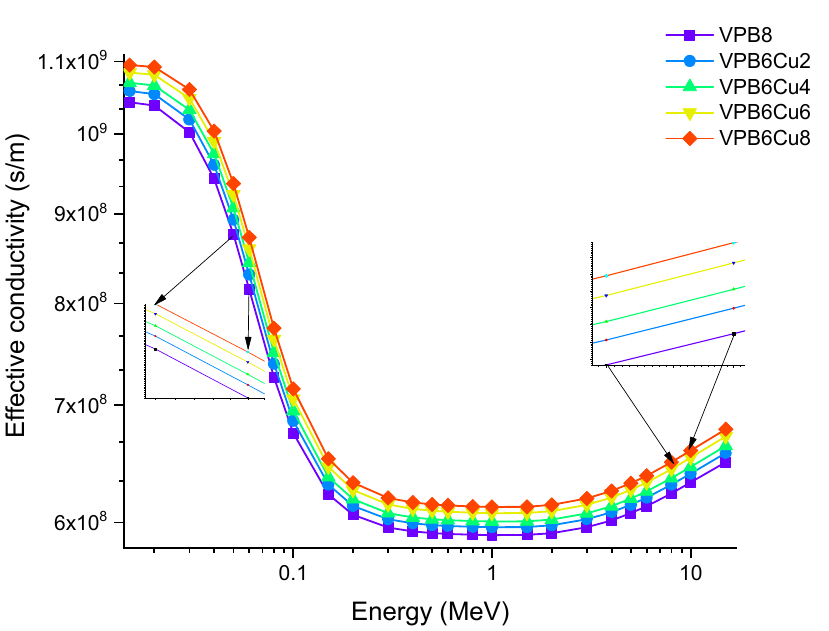
Figure 16. Variation of effective conductivity (C eff ) at 300K (s/m) for VPB x Cu y glass samples.